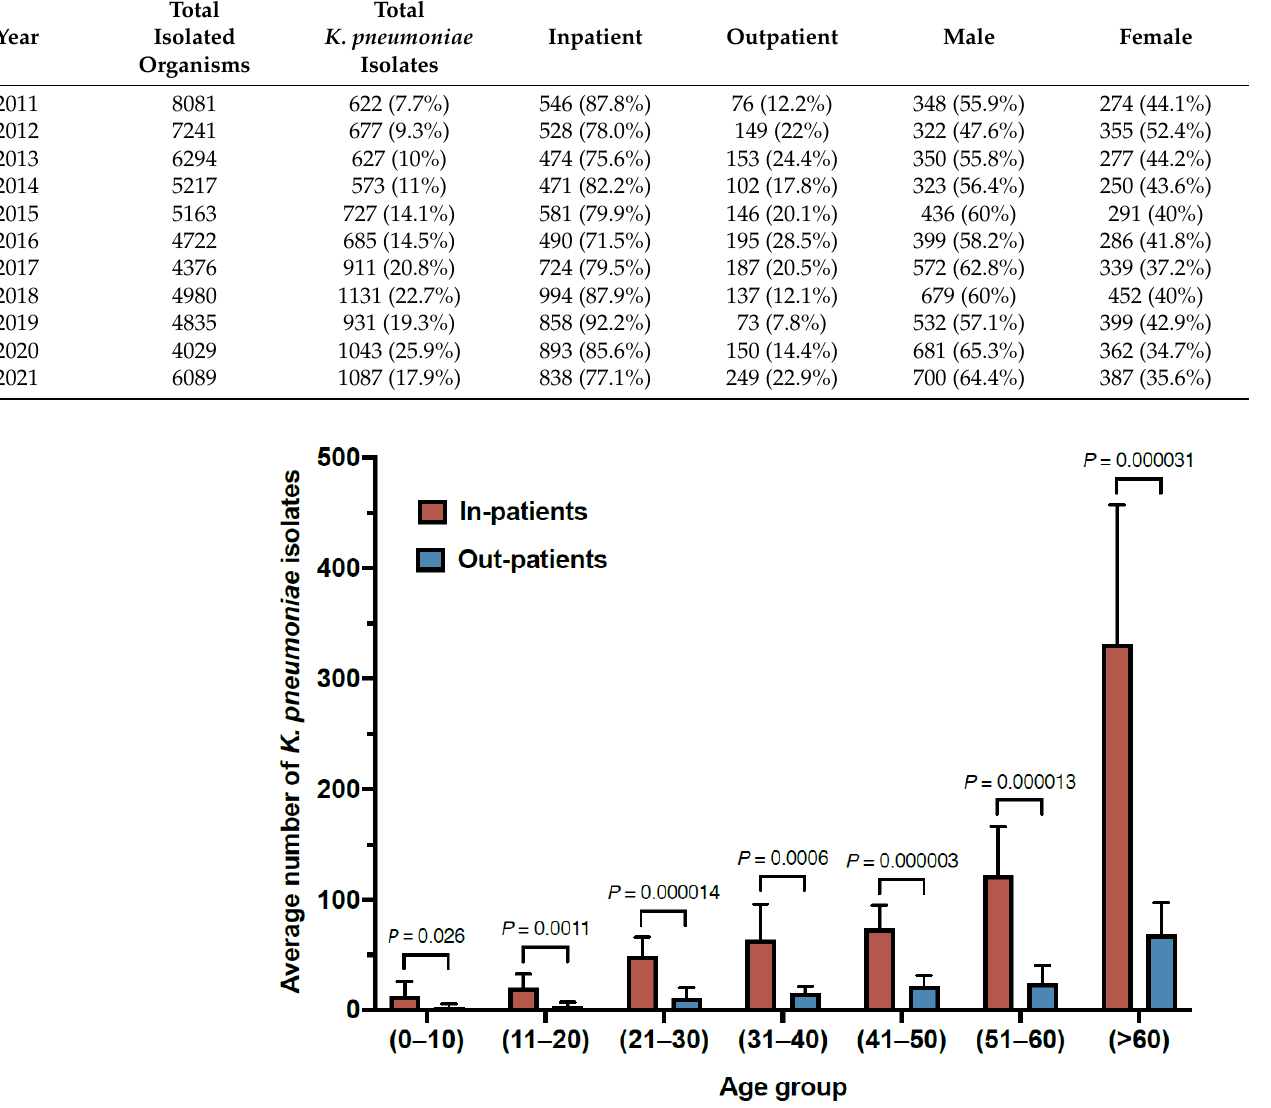
Figure 1. The distribution of K. pneumoniae isolates from inpatient and outpatient departments from 2011 – 2021.